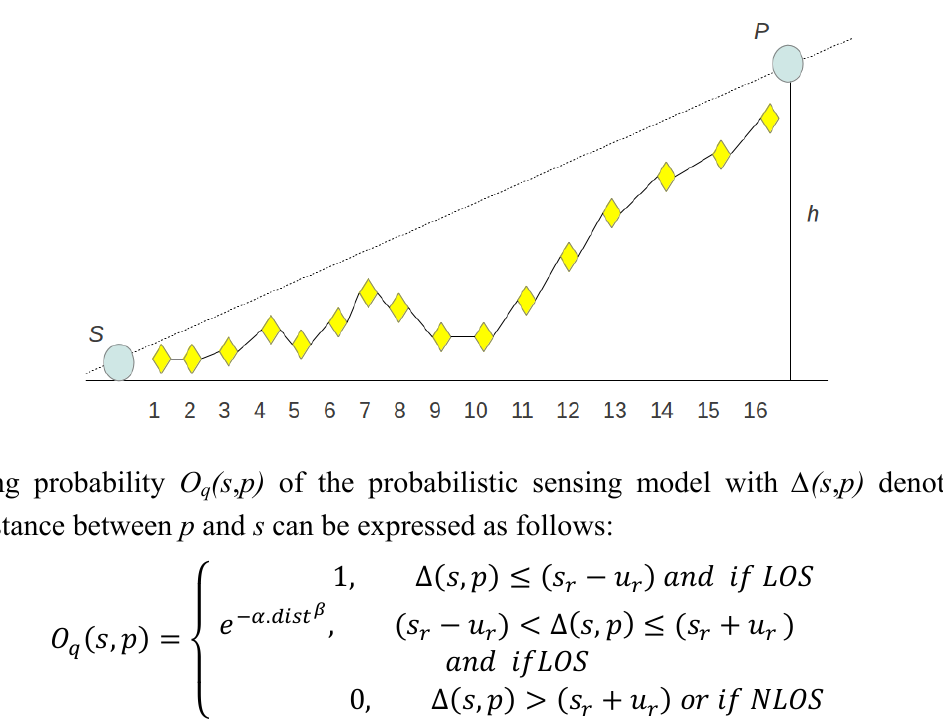
Figure 3. Determination of LOS between a sensor and a